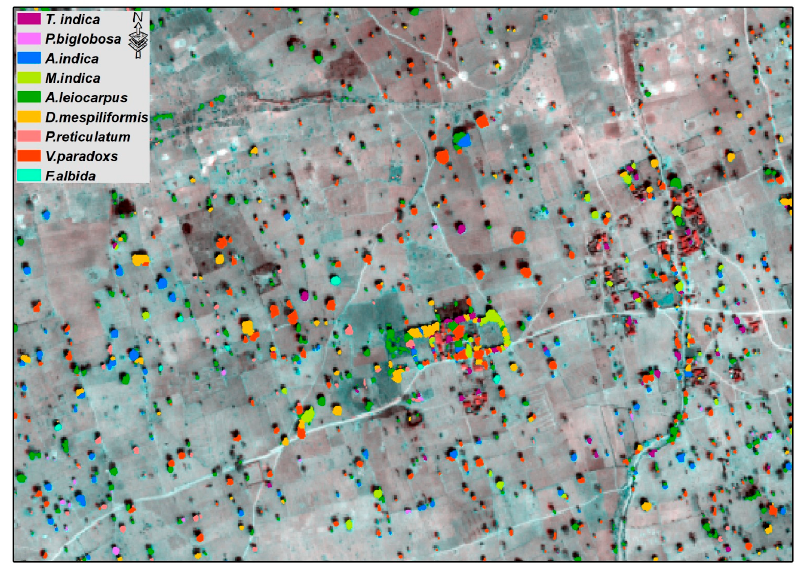
Figure 5. Map of the spatial distribution of tree species in a small portion of the study area.